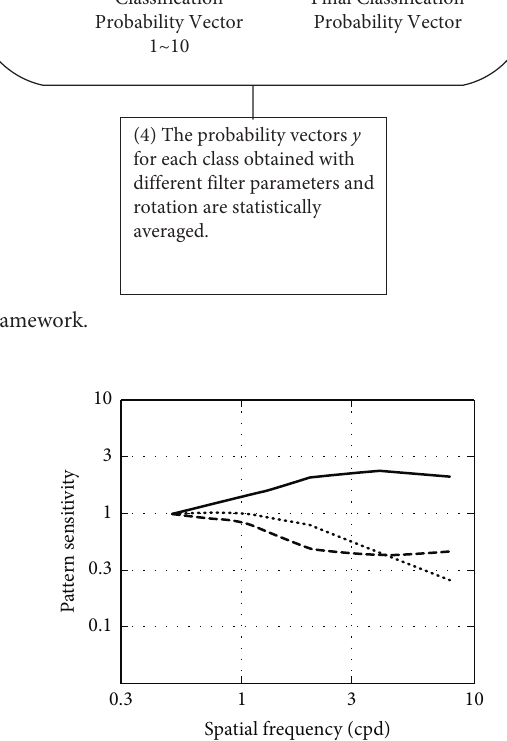
Figure 3: Color and pattern sensitivity functions [29]. The solid curve shows the sensitivities of the white-black, the dotted curve shows the red-green, and the dashed curve shows the blue-yellow. The white-black sensitivity is the highest among the three at any certain spatial